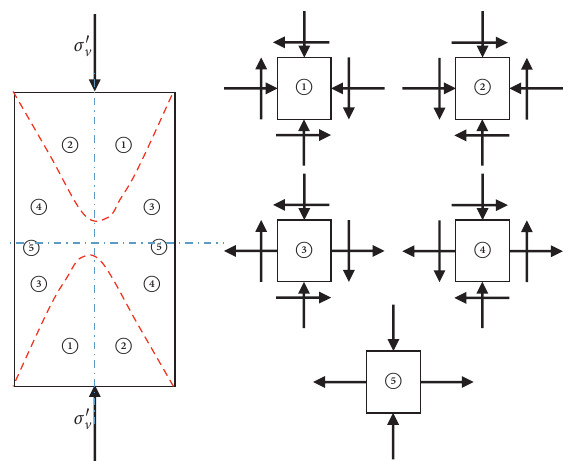
Figure 3: Stress distribution of uniaxial compression specimen considering friction.